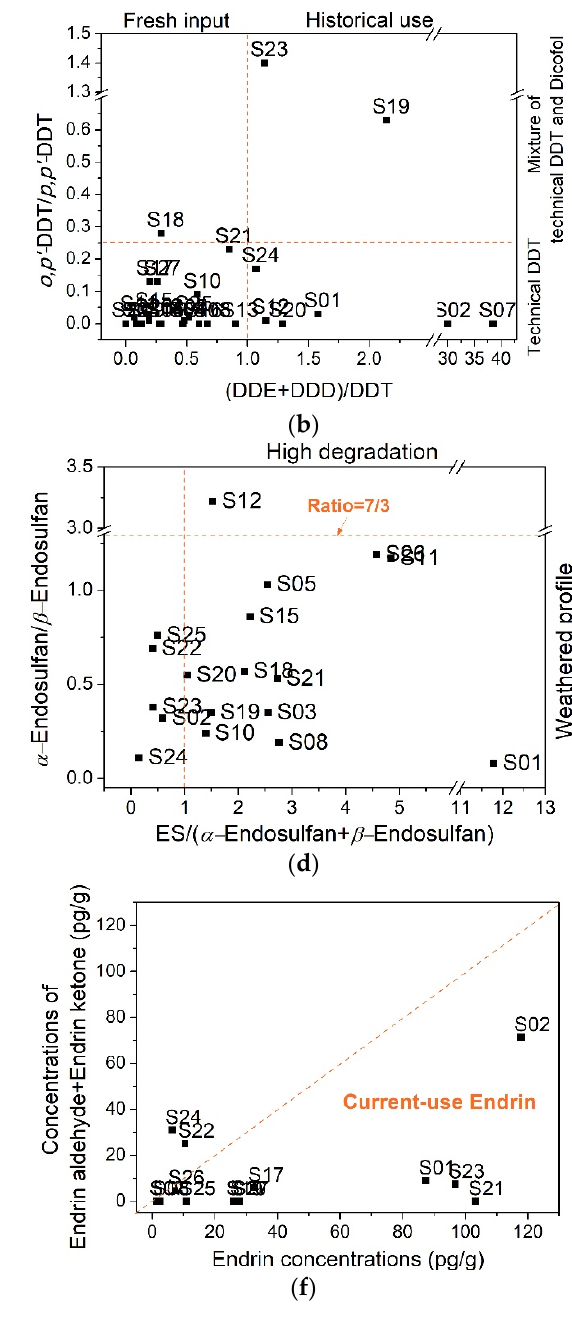
Figure 4. Isomeric and metabolic ratios for identifying the sources of HCH ( a ), DDT ( b ), chlordane ( c ), endosulfan ( d ), aldrin ( e ), and endrin ( f ) in the study karst soil. Some samples were not plotted because of undetectable target OCP compounds. Results showed the possible current uses of lindane, technical DDT, aldrin, and endrin in the soil.